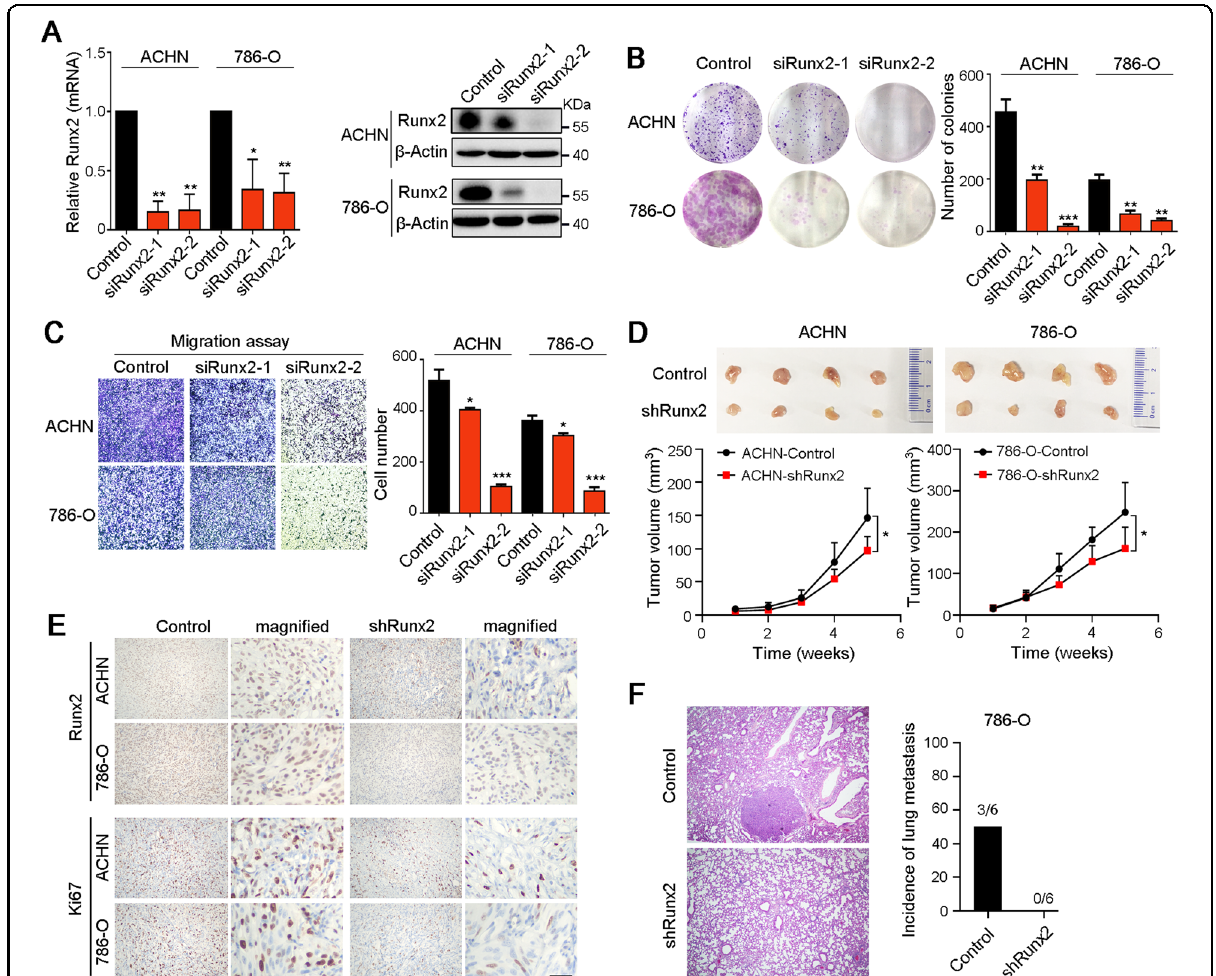
Fig. 3 Knockdown of Runx2 attenuates the growth and metastasis of ccRCC cells. A Two siRNAs were used to downregulate the expression of Runx2 in ACHN and 786-O cells, and the knockdown of Runx2 was con fi rmed by qRT-PCR and western blot analyses, respectively. B Interference of Runx2 decreased the foci formation frequencies of ccRCC cells. C Transwell migration assay was performed to explore the effect of Runx2 on the migration ability of ccRCC cells. D ACHN and 786-O cells after knockdown of Runx2 were subcutaneously injected into nude mice, and the tumor volumes were measured every week ( n = 4 mice per group). E IHC staining with antibodies against Runx2 and Ki67 in xenograft tumors derived from ACHN and 786-O cells with or without Runx2 silencing. Scale bar, 25 μ m. F Nude mice were treated by tail intravenous injection of 786-O cells with or without Runx2 knockdown. Hematoxylin – eosin staining con fi rmed the lung metastasis, and the incidence of metastasis was indicated in right panel ( n = 6 mice per group). Scale bar, 50 μ m. In all panels, *, P < 0.05; **, P < 0.01; ***, P <